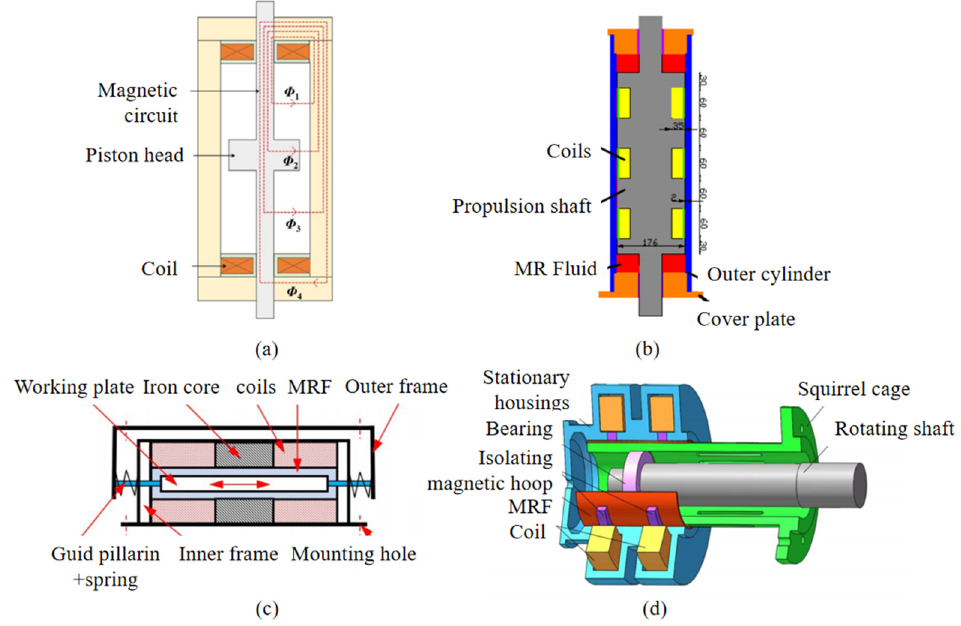
Figure 3. MRD with improved number of coils and coil arrangement: ( a ) The coil is separated from the piston head [32]. ( b ) Three-coil MRD with embedded Hall sensor [33]. ( c ) Double-coil 2D planar plate MRD [34]. ( d ) Double-coil rotor system